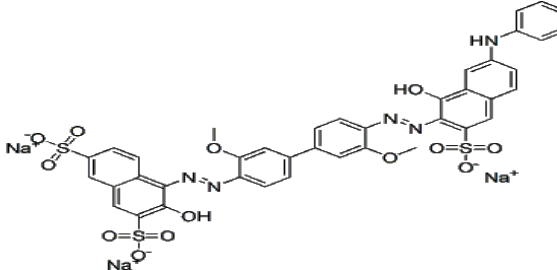
Figure 4: Direct Blue BRL(201) (Shams Nateri, Dehnavi et al. 1391)